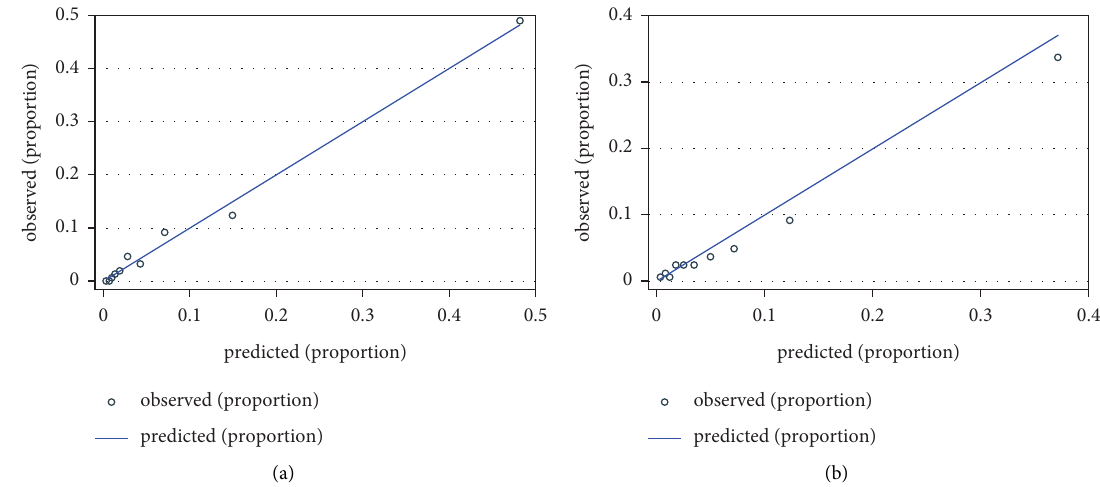
Figure 2: Te Hosmer-–Lemeshow calibration curve for the model predicting probability of NOAF in ACS patients. (a) Calibration curve for the model in the training cohort; (b) the calibration curve for the model in the validation cohort. X -axis is predicted probability by model and y -axis is actual probability of